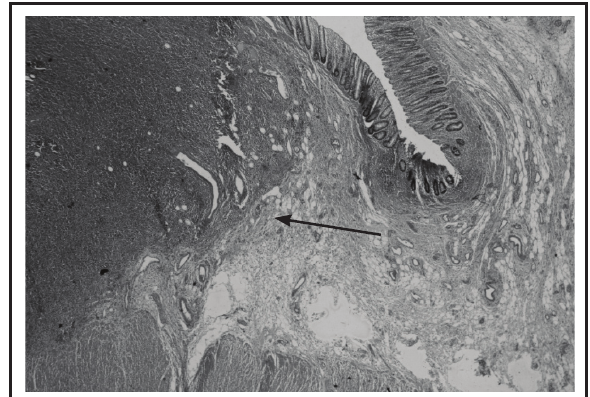
Figure 3. Photomicrograph showing mucosa, submu - cosa and muscularispropia of the rectum with diffuse infiltrates of submucosa with tumor cells (arrow) ex - tending upto mucosa and muscularispropria. (H&E stain, 20X)